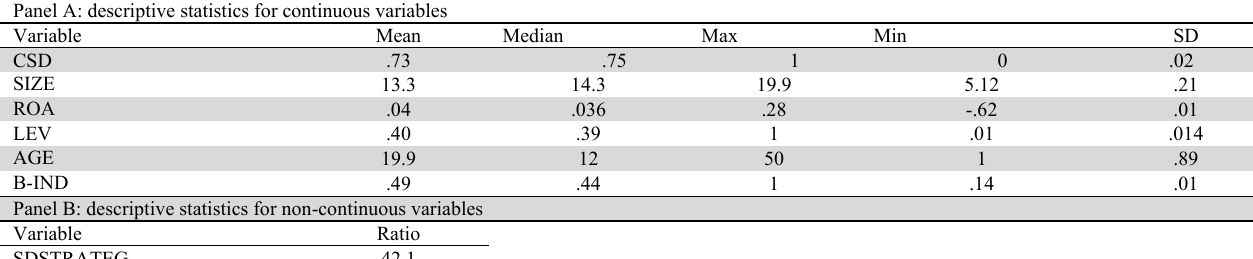
Panel B: descriptive statistics for non-continuous variables